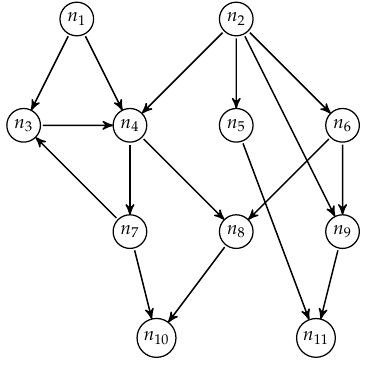
Figure 5. Network with a